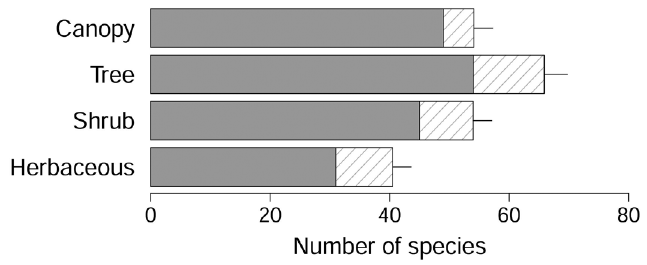
Fig. 12. Specific richness in the different vegetation strata; grey = observed richness; dashed chart = estimated richness (ACE index) and associated standard